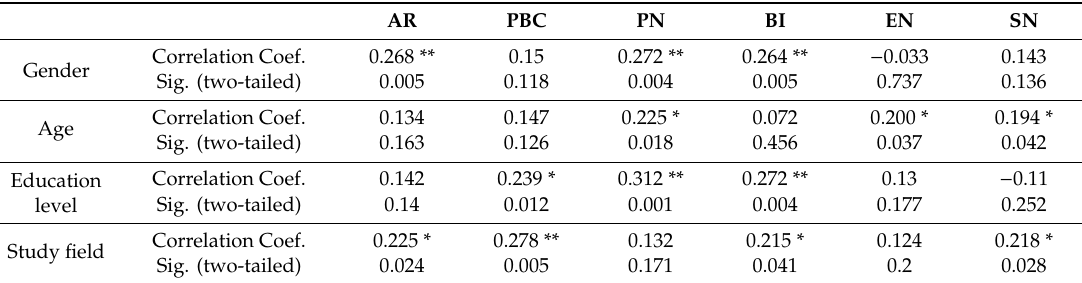
Table 13. Correlation analysis